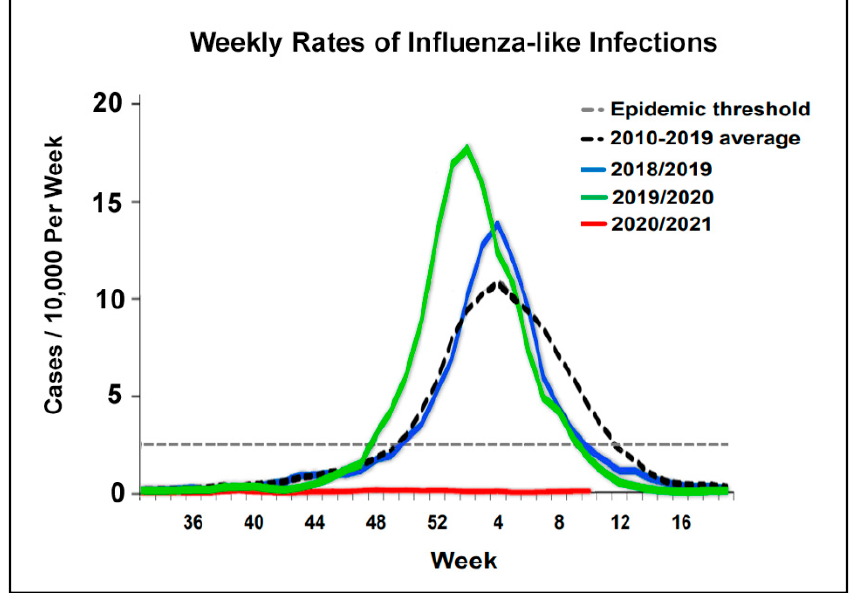
Figure 4. Weekly rates of influenza-like infections during the winter weeks. A noticeable absence of influenza-like infections during the pandemic of 2020/2021 compared to previous years and the previous ten-year average. Figure adapted from a published report of the Israel Center for Disease Control, Israel Ministry of Health [10].